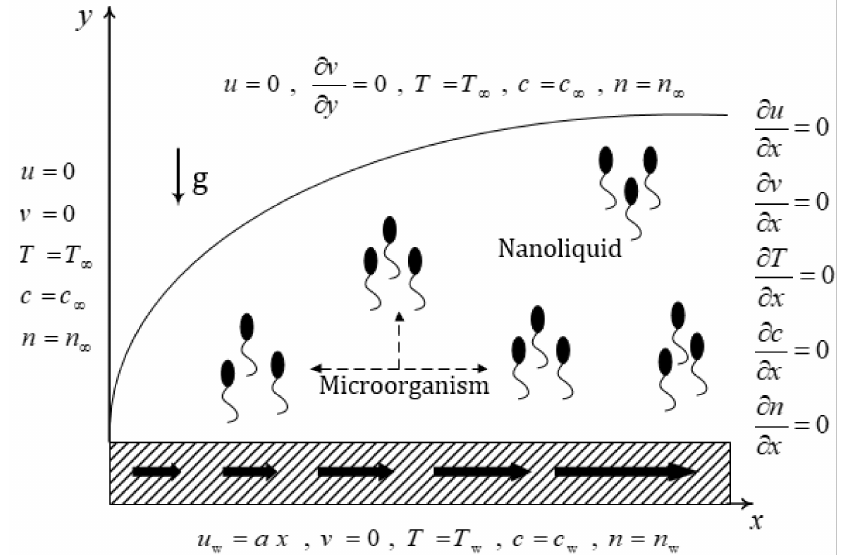
Figure 1. Schematic problem description. The quantities apply to the regions as they are written: sheet surface (bottom), beginning of the sheet (left-hand side), end of the sheet (right-hand side), and far-field (top); the arrows in the sheet show the directions of the fluid flow and gravity